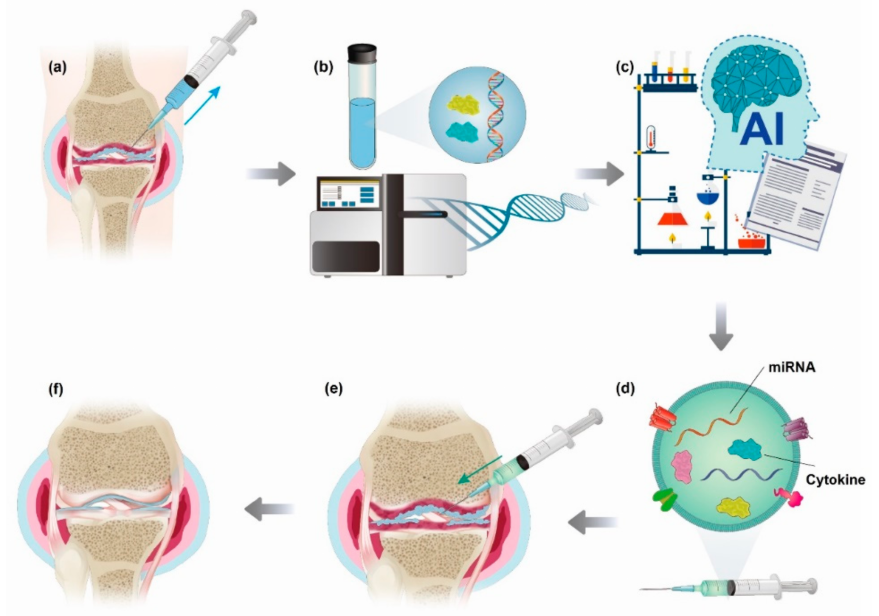
Figure 3. The future paradigm of osteoarthritis (OA) treatment. ( a , b ) After analyzing the patient genome and joint synovial fluid, ( c ) we can find crucial factors including proinflammatory cytokine and miRNA for chondral damage of each patient based on big data and artificial intelligence (AI). ( d ) We can arrange a personalized ideal exosome to control the key OA pathway by applying enhancing miRNA and exosome packaging techniques. ( e ) Single or twice injection for local delivery and ( f ) promoting cartilage regeneration and recovery to normal joint